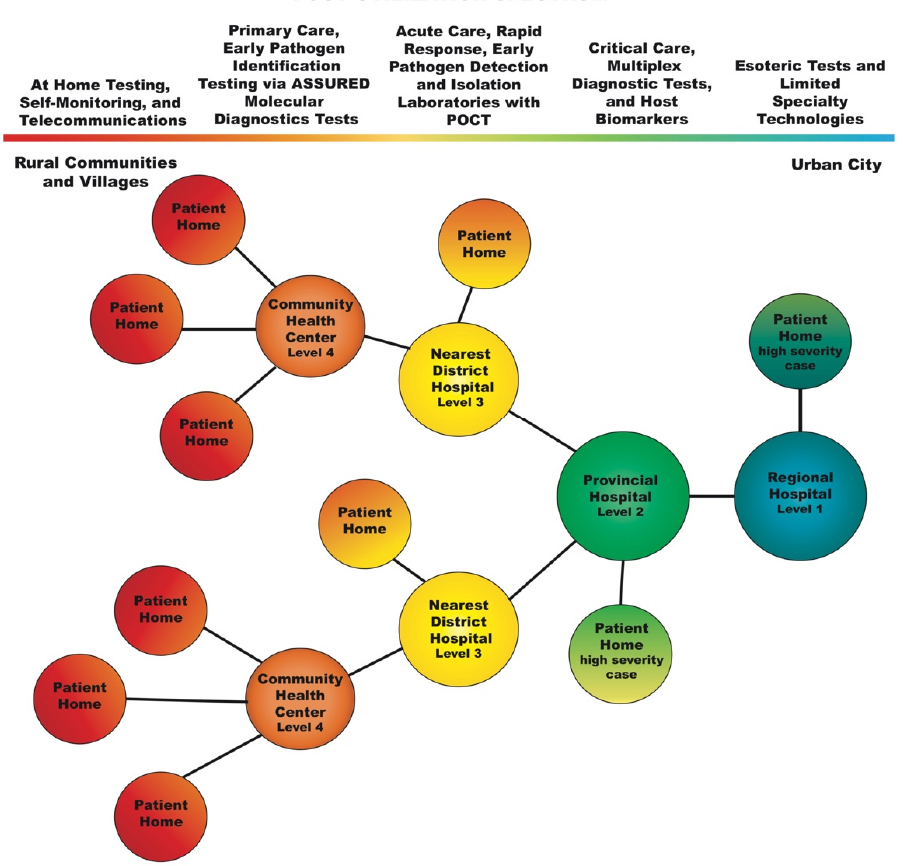
Figure 4 . Healthcare network and point-of-care testing spectrum . Limited resource settings in rural communities and villages can take advantage of the POCT spectrum for accessibility to diagnostic testing near their homes, which maximizes healthcare efficiency. The current healthcare network requires patients in rural communities to travel over an hour for diagnosis and interventional care.